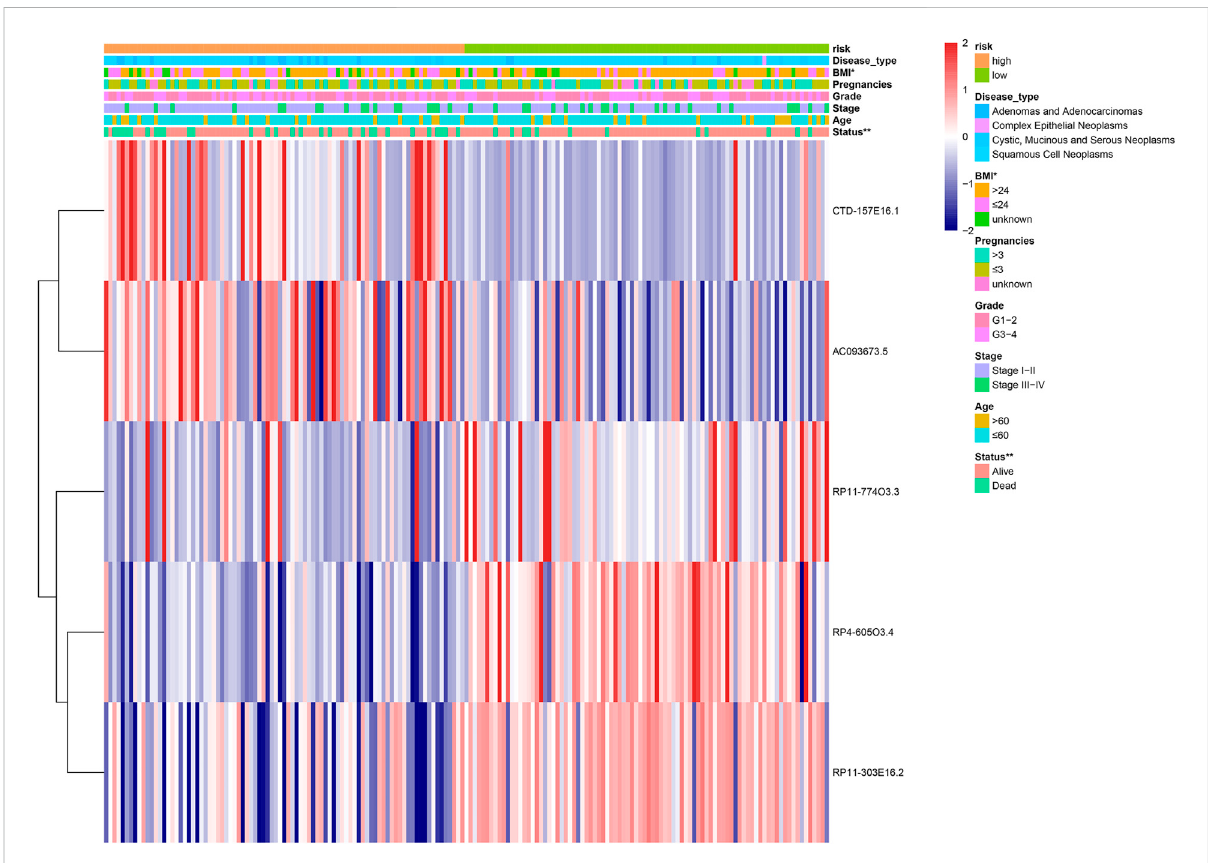
FIGURE 4 The heatmap showing the fi ve-lncRNA expression in high and low cervical cancer (CC) patients. The CC-associated clinicopathological parameters was investigated between the high- and low-risk groups. * p < 0.05, ** p <